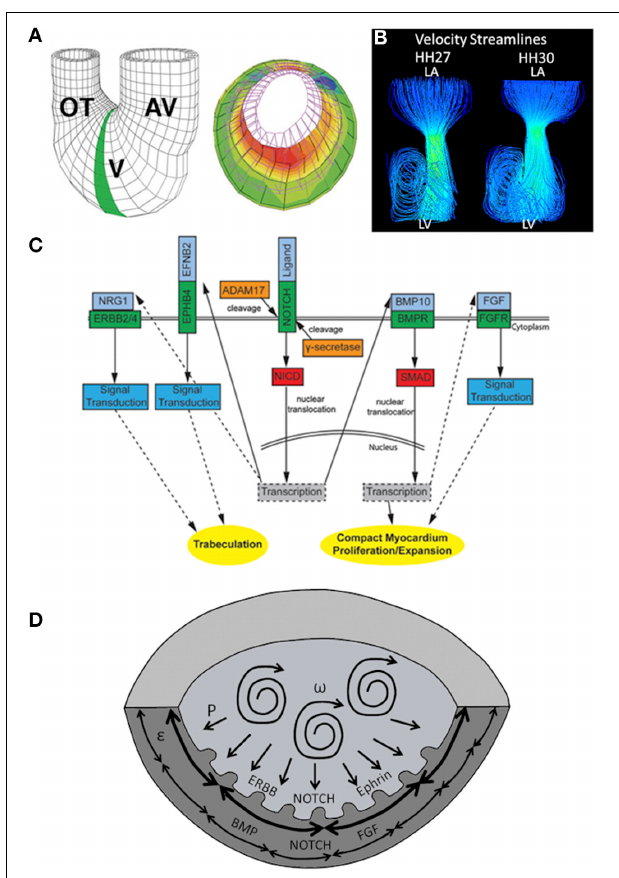
FIGURE 3 | Mechanical forces driving chamber development. (A) A computational model showing that inner trabecular layers undergo greater strain that outer compact layer in ventricular chamber. AV, atrioventricular canal; V, ventricle; OT, outflow tract. Adapted from Damon et al. (2009). (B) Velocity streamlines in left AV canal for HH27 and for HH30 chicken embryos, generated with computational fluid dynamics. Strong vortices develop in the ventricular cavity, possibly necessary for the expansion of the chambers. Adapted from Yalcin et al. (2011). (C) Signaling pathways in ventricular chamber maturation. NOTCH, ERBB, and Ephrin play role in trabeculation whereas NOTCH, BMP, and FGF play role in compact myocardium development. Adapted from Samsa et al. (2013). (D) Proposed ventricular chamber development model. Circulatory flows cause expansion of the ventricles. Pressure induces a gradient in circumferential strain in the trabeculae and compact myocardium. This gradient cause a difference in myocyte proliferation as well as different gene expression profiles. P represents pressure, ω represents circulations, and ε represent circumferential strain.